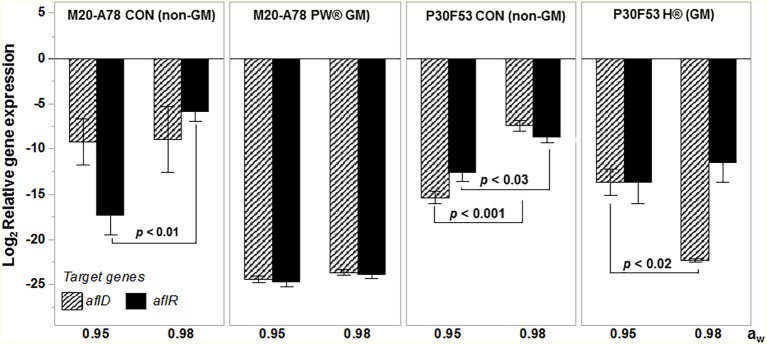
Effect of biocontrol using the Brazilian AFL4−:AFLb+ mixed non-toxigenic and toxigenic strain 50:50 ratio inoculum on the relative gene expression of the structural aflD and regulatory aflR genes on one of the non-GM and isogenic-GM cultivars stored post-harvest at both 0.98 and 0.95 water activity. The values of p show differences in overall AFB1 content comparing GM and non-GM maize at 5% significance. Bars represent mean ± SE.